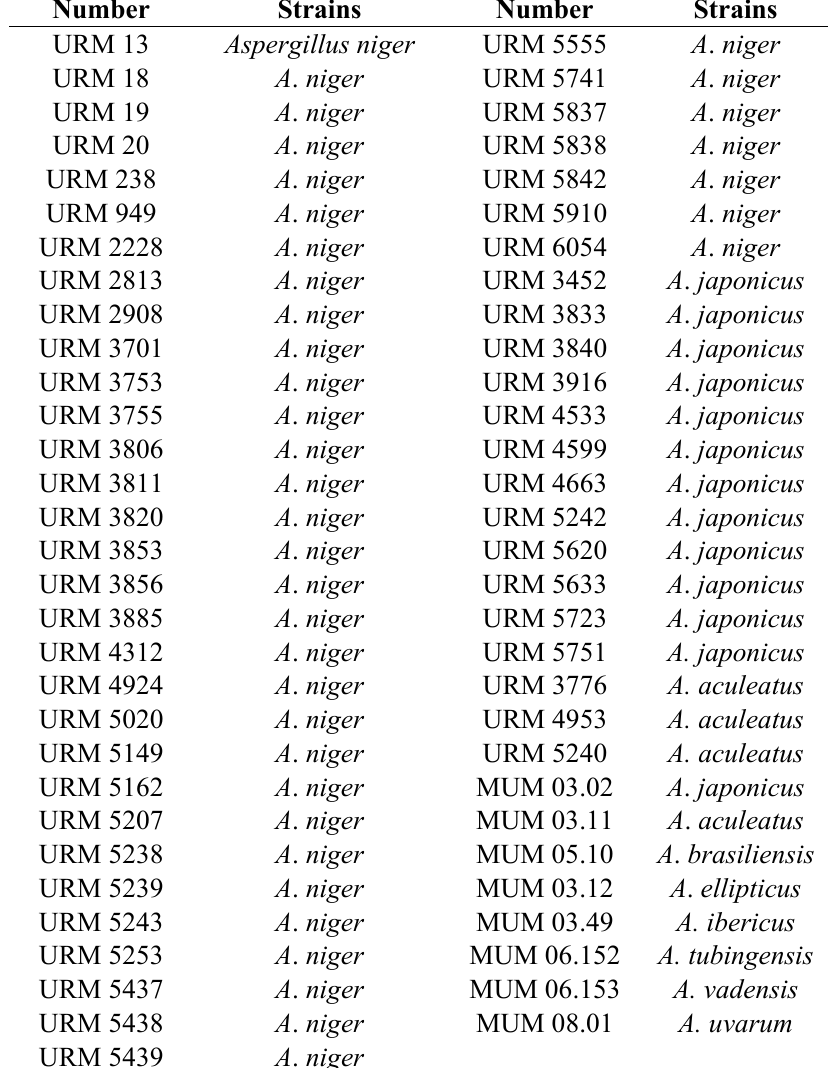
endo-polygalacturonase and